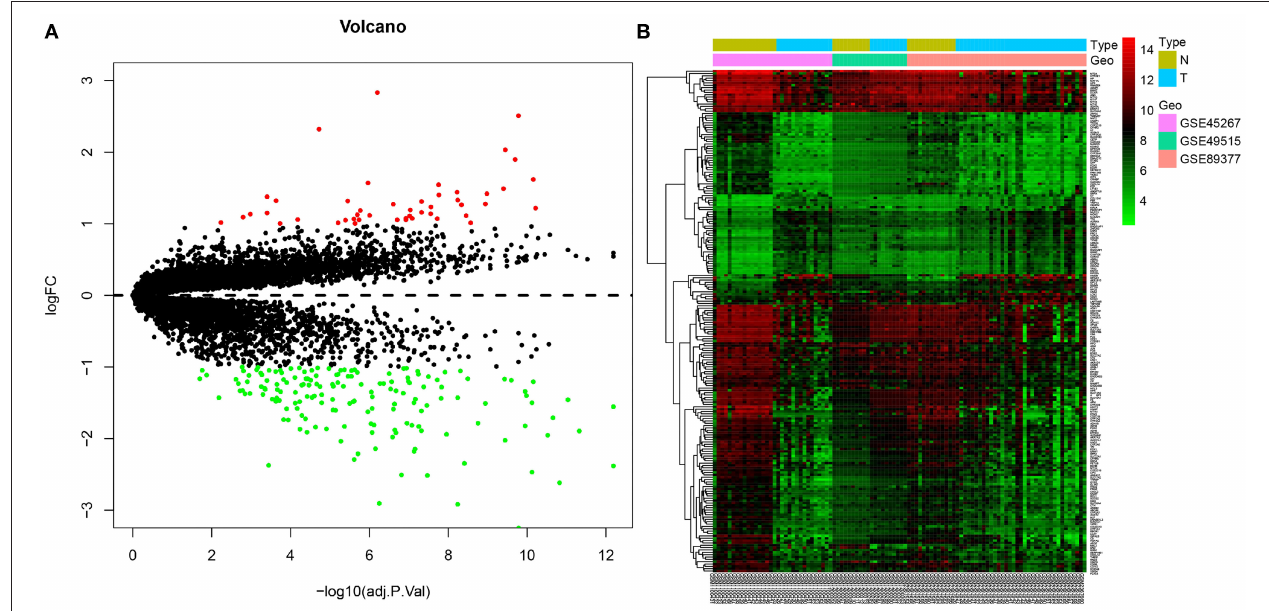
FIGURE 3 | Joint differential analysis of HCC-related expression datasets in the GEO database. (A) , A volcano map for differentially expressedf genes in the GSE45267, GSE49515 and GSE89377 datasets downloaded from the GEO database. (B) , A heatmap of the differentially expressed genes in the GSE45267, GSE49515 and GSE89377 datasets downloaded from the GEO database. The X-axis represents the sample number, the Y-axis represents the gene name, the left dendrogram represents the gene expression clustering, and the upper right histogram is the color scale.